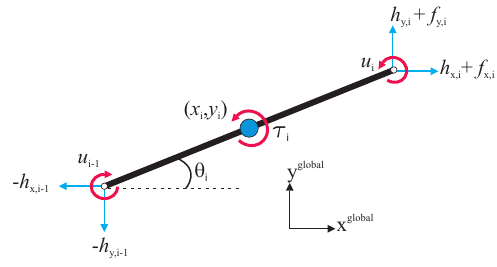
Figure 2. Forces and torques acting on each link of the underwater snake